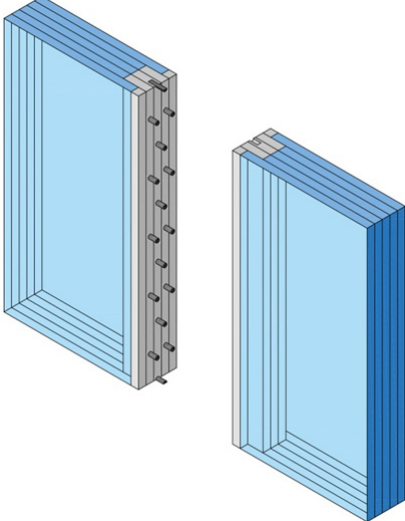
Fig. 2 Transfer of shear force between the profiles, by dowel